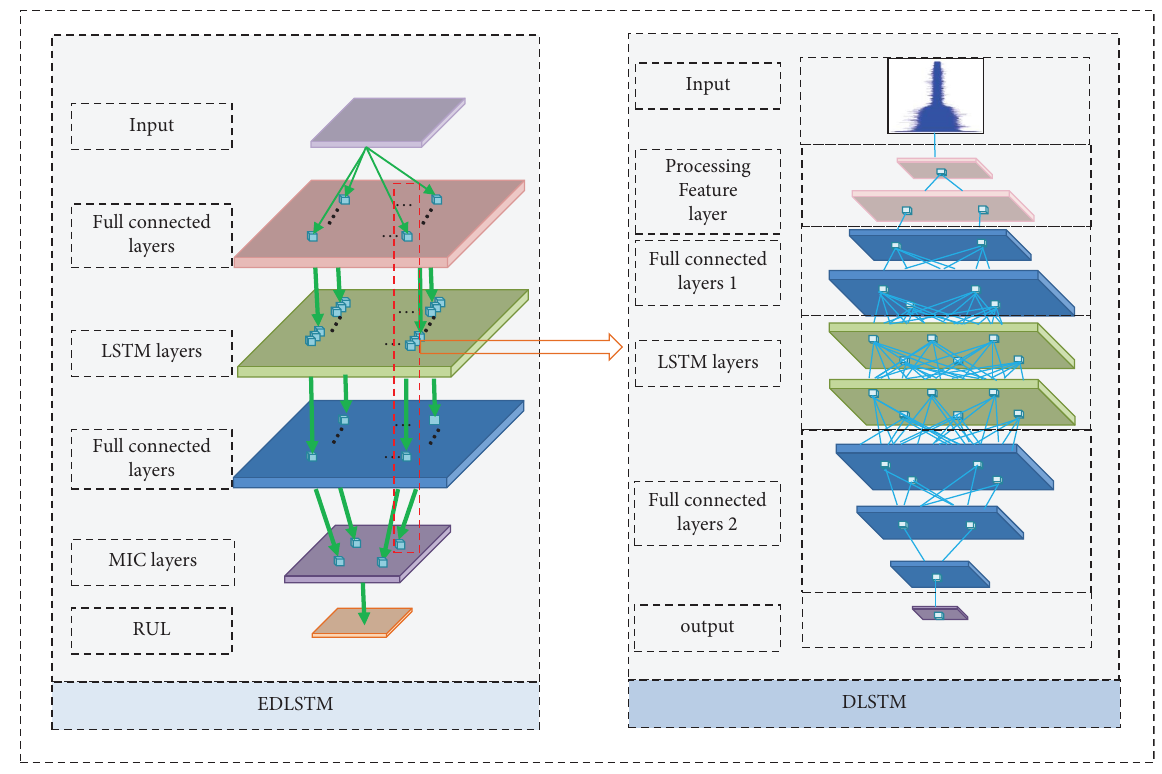
Figure 4: A framework for the EDLSTM predictive